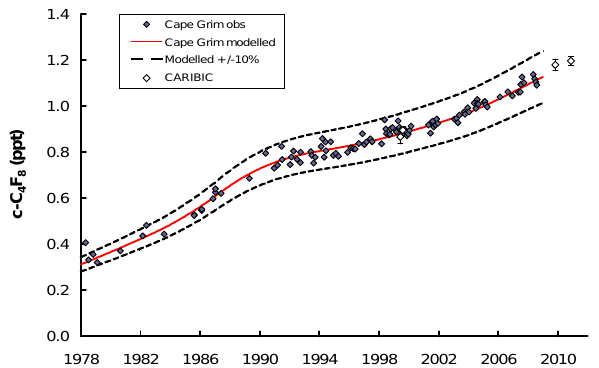
Fig. 1. Measured and modelled c-C 4 F 8 in the Southern Hemisphere over the period 1978–2010. Blue diamonds are individual samples collected at Cape Grim, Tasmania (41 ◦ S); open diamonds are mean mole fractions (with ± 1 σ) from CARIBIC flights in 1998, 2009 and 2010. The 1998 CARIBIC samples are from the Nnorthern Hemisphere and have been shifted by +1yr to allow for interhemi- spheric mixing. The 2009 and 2010 CARIBIC data are southern hemispheric samples only. For clarity the uncertainty of the indi- vidual Cape Grim data points (mean precision = 0.8%) have been omitted. The red line represents the model-derived mole fractions, with the dashed lines showing the effect of a ± 10% change on the modelled